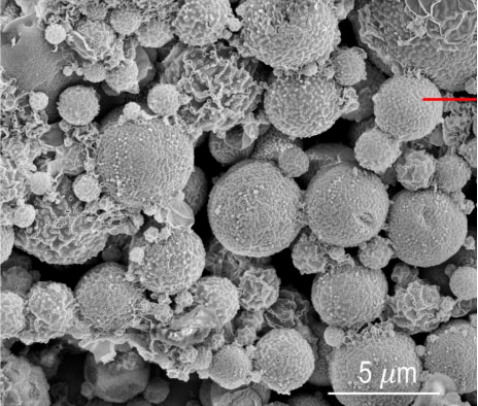
Figure 5. Particle size measurements of polysulfone (PS) and polyacrylic acid (PAA) co-polymer by SEM [21]. Table 1. Performed studies using SEM for characterization of polymeric membranes.